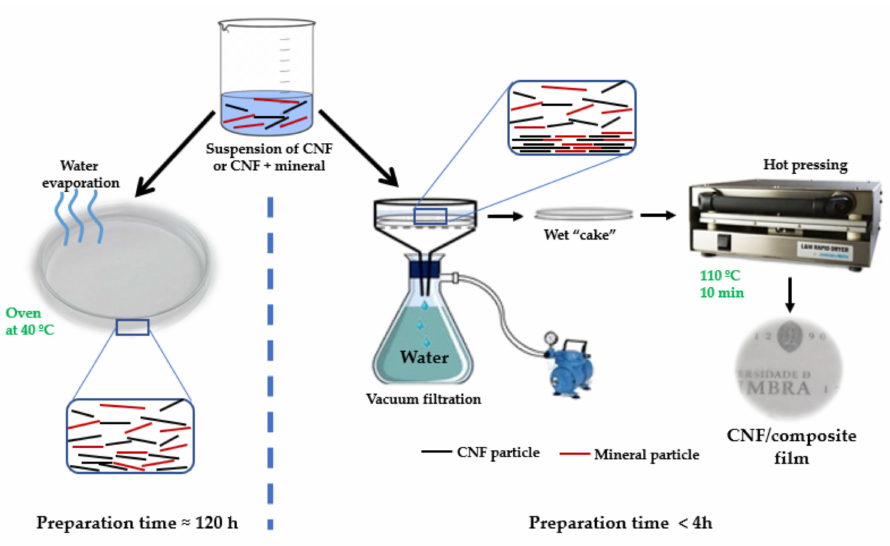
Figure 1. Illustration of the procedures used to prepare the CNF-based composite